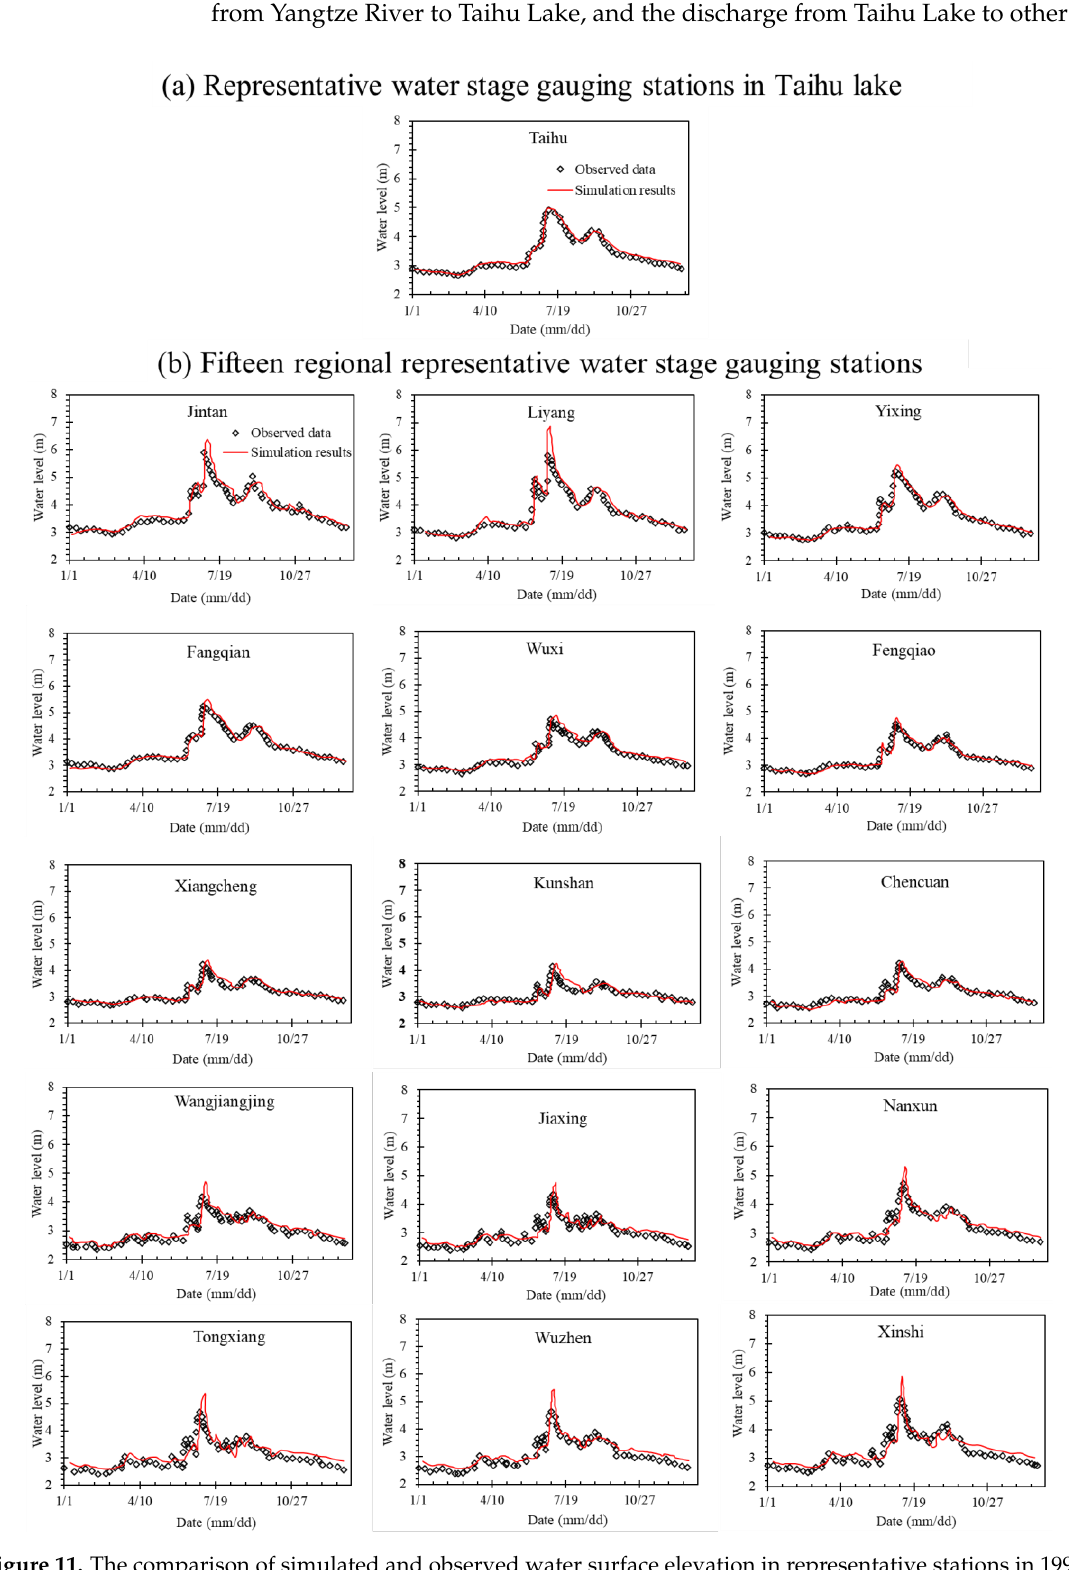
Figure 11. The comparison of simulated and observed water surface elevation in representative stations in 1999.